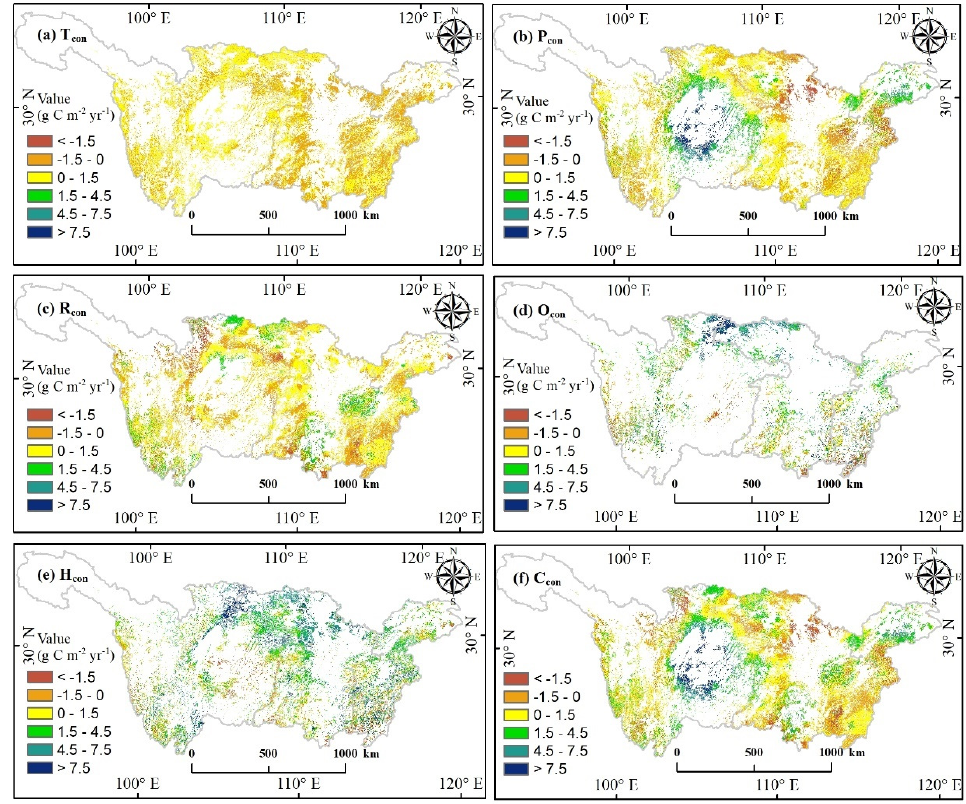
Figure 6. The contributions of climate factors and human activities to net primary productivity (NPP) trend from 2000 to 2019 in YRB, China. ( a ) temperature, ( b ) precipitation, ( c ) solar radiation, ( d ) other climate factors, ( e ) human activities, and ( f ) climate.